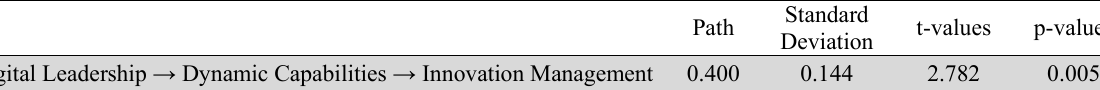
Simultaneous Hypothesis Testing